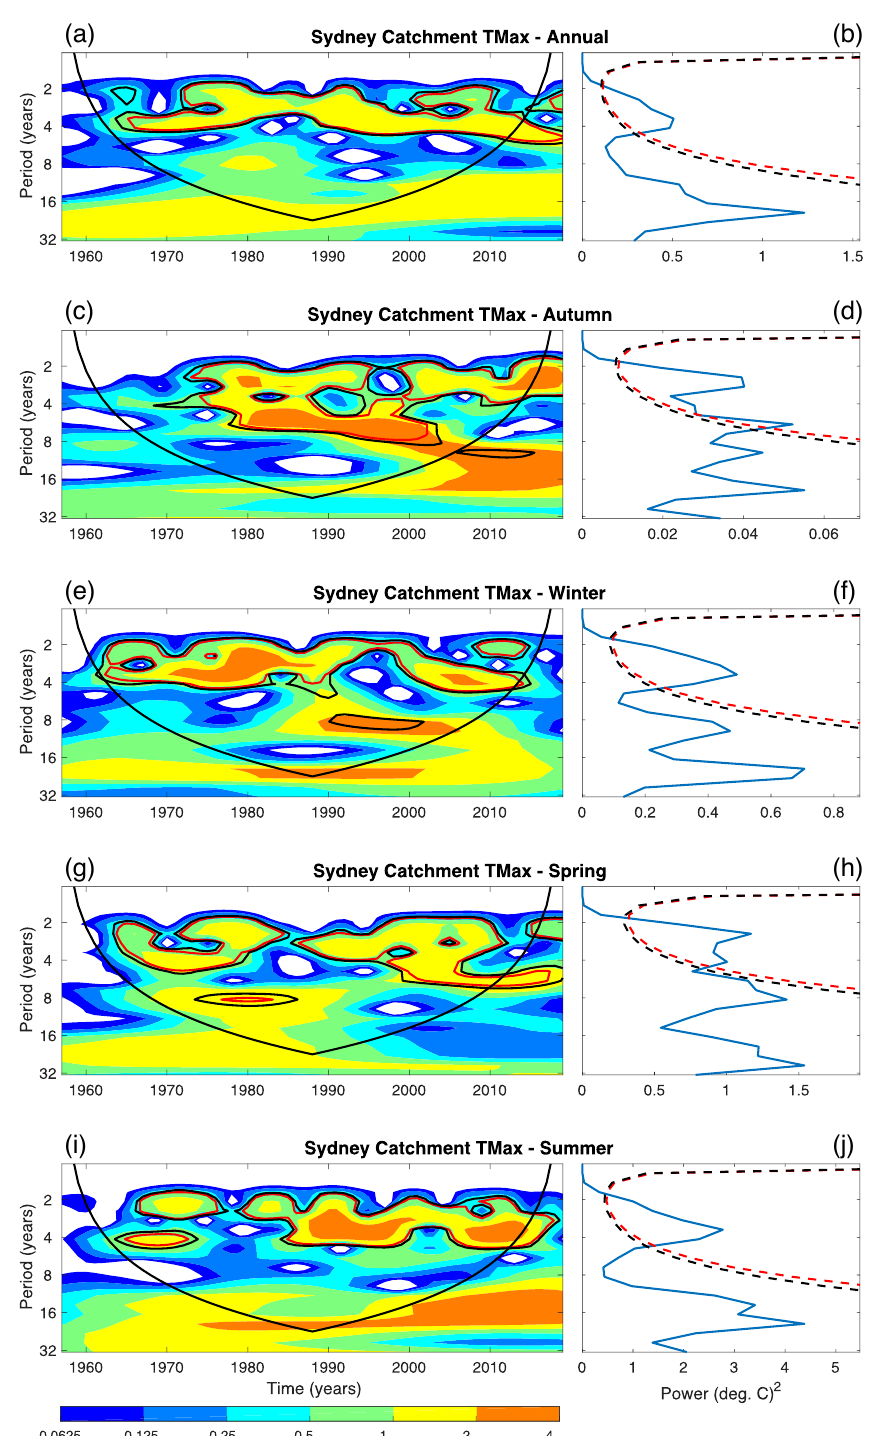
Figure 7. Wavelet power spectra (left panel, ( a , c , e , g , i )) and global power spectra (right panel, ( b , d , f , h , j )) for TMax, with low and high values in the power spectra indicating low and high periodicity, respectively; the cone of influence and statistical significance bands as already explained in Figure